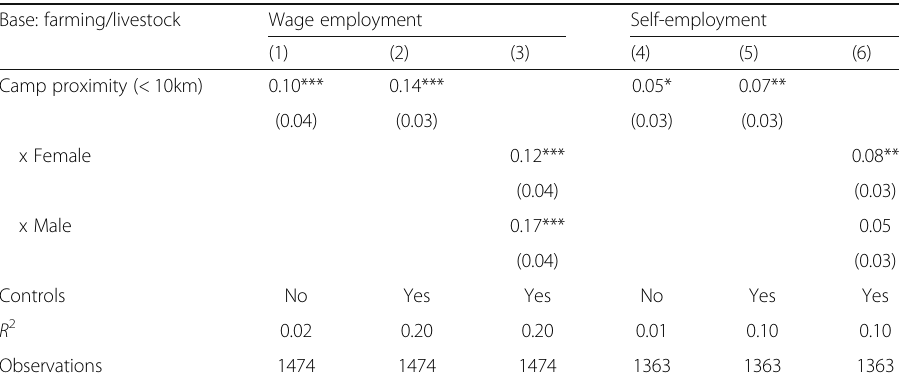
Base: farming/livestock Wage